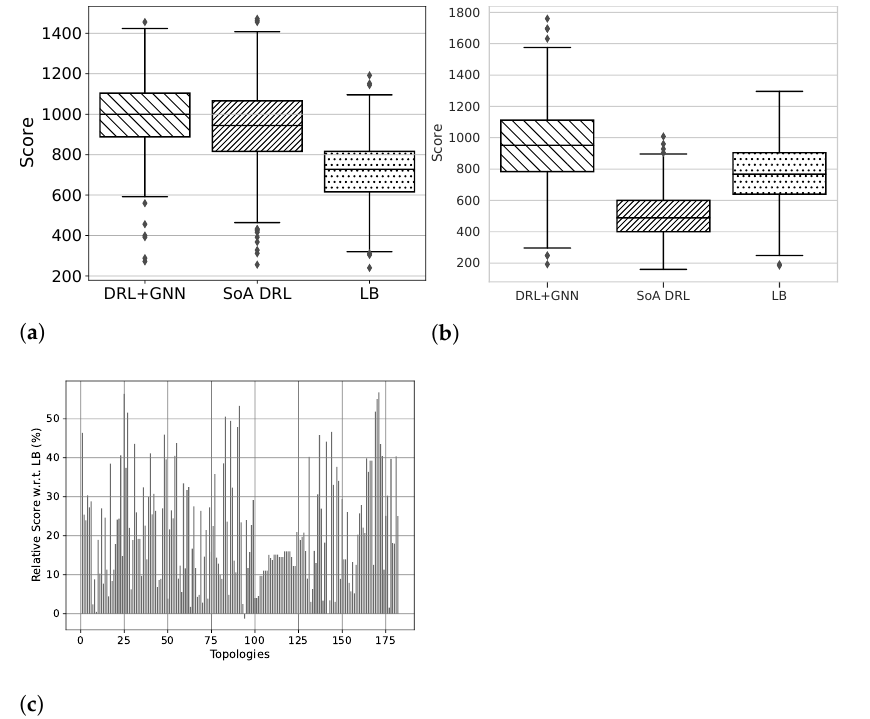
Figure 2. Evaluation of our DRL + GNN agent for routing optimisation in optical transport net- works: ( a ) Training/Evaluation in the same topology (NSFNet); ( b ) Training/Evaluation in different topologies (trained in NSFNet; evaluated in Geant2); ( c ) Evaluation of our DRL + GNN agent over 136 topologies from Internet Topology Zoo unseen during the training